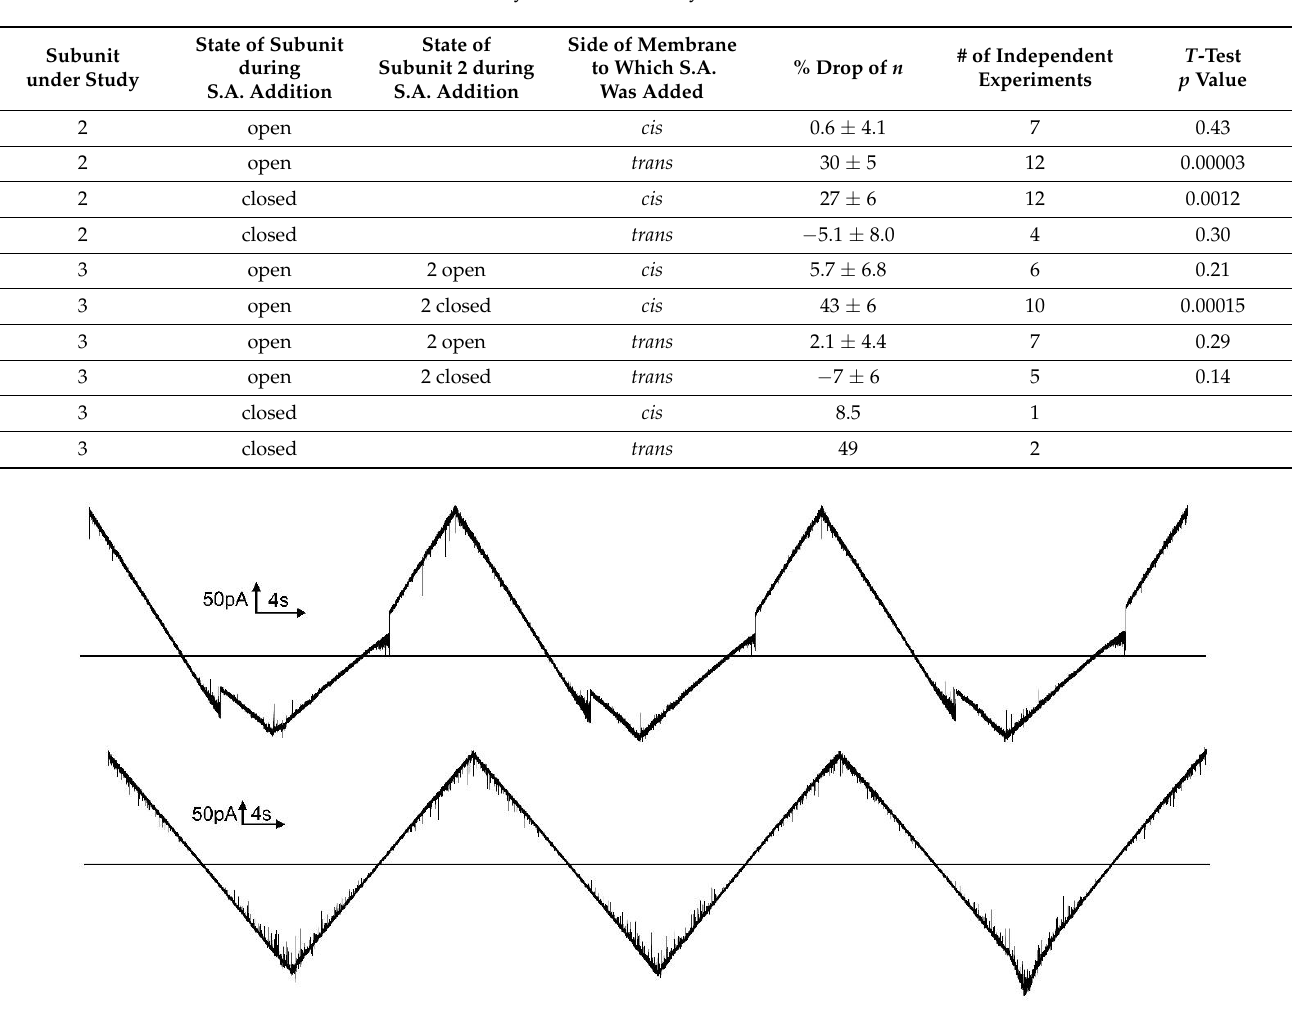
Figure 8. Trypsin added to the trans compartment cleaved the sensor of subunit 2. The upper trace was recorded before trypsin addition (triangular wave +81/ − 79 mV; 30 mHz). A constant 10 mV was applied followed by trypsin addition (60 ug to the trans compartment). After 10 min of trypsin treatment, 1 mg of soybean trypsin inhibitor was added to the trans compartment and the triangular voltage wave was resumed (lower trace).